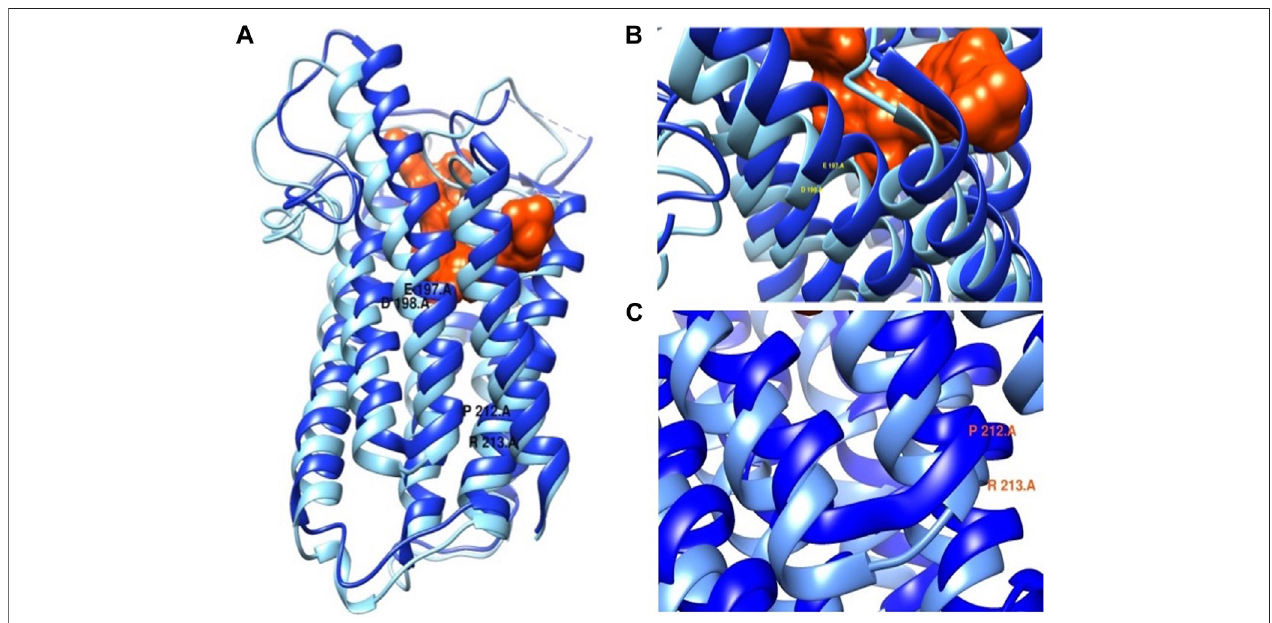
FIGURE 5 | (A) SRD5A2 protein structure. (B) Mutation p.Glu197Asp close-up. (C) Mutation p.Pro212Arg close-up. In dark blue wild protein and in light blue mutated protein. The protein is in complex with fi nasteride